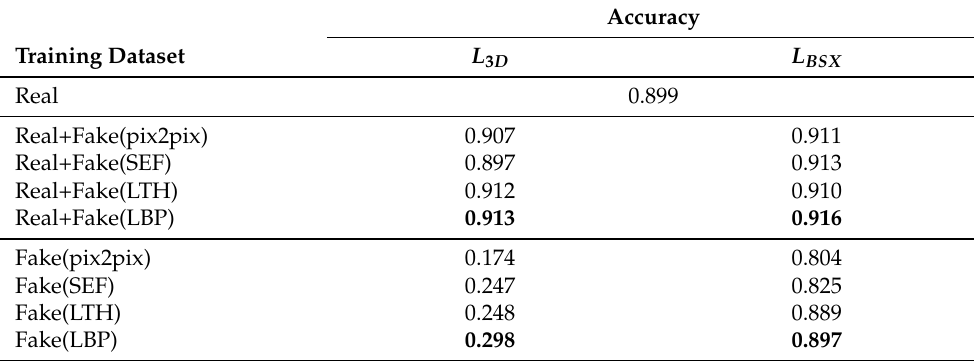
Table 4. Detection accuracy according to the training